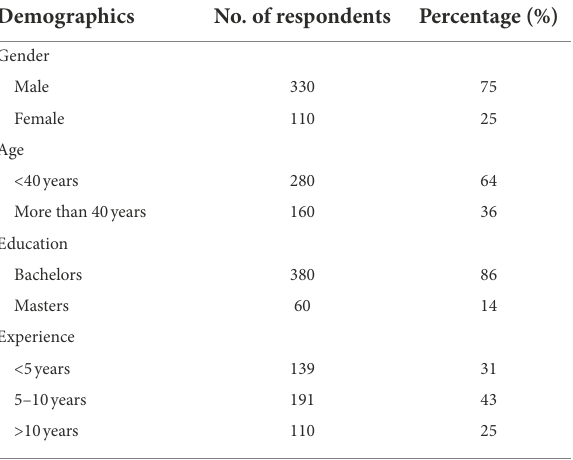
TABLE 6 Construct validity. TABLE 4 Profile of the respondents.